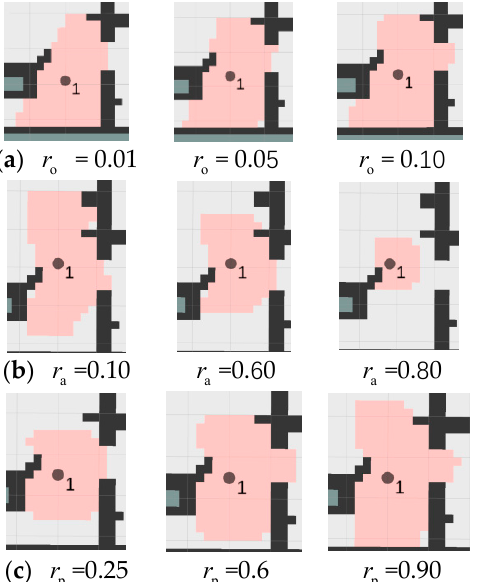
Figure 8. The influence of three parameters on the construction of the topological map. ( a ) Impact of changes in the obstacle ratio on the region. ( b ) Impact of changes in the point addition ratio on the region. ( c ) Impact of changes in the points pass ratio on the region.